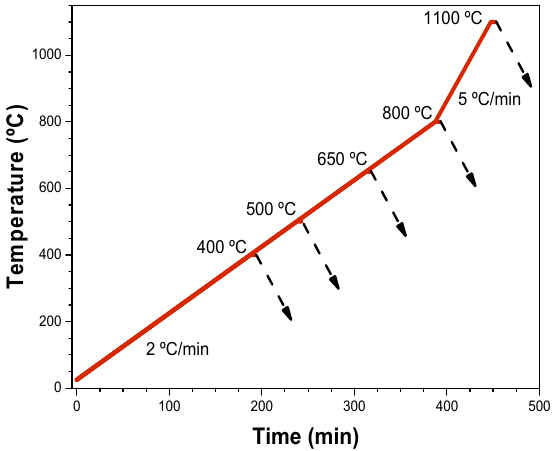
Figure 1. Thermal treatments performed under high-vacuum conditions. The dotted lines show the temperatures at which samples were cooled down in order to examine their phase composition and microstructure at intermediate stages of the dehydrogenation process.